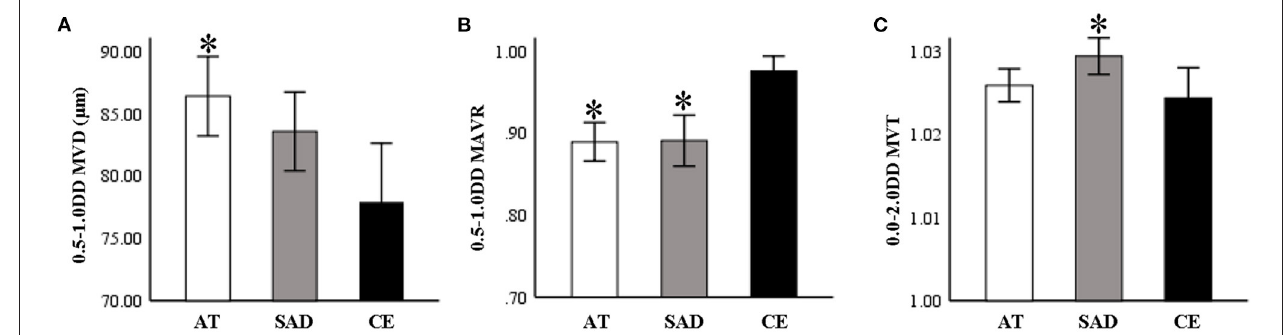
FIGURE 4 | (A) AT subtype group had the widest MVD 0.5 − 1.0DD ( P = 0.047). (B) CE subtype group had the highest MAVR 0.5 − 1.0DD ( P = 0.010). (C) The SAD subtype group had the largest MVT 0.0 − 2.0DD ( P = 0.024). AT, atherothrombosis; SAD, small artery disease; CE, cardioembolism; DD, disk diameter; MVD, mean venular diameter; MAVR, mean arteriovenous ratio; MVT, mean venular tortuosity. * P < 0.05, compared to CE.